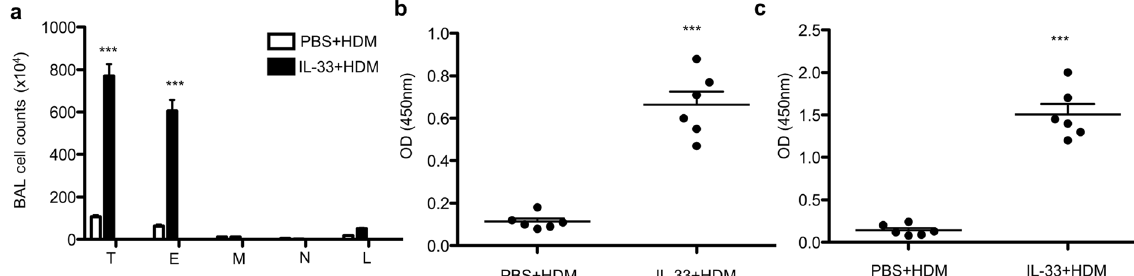
Figure 3. Skin sensitization with HDM + IL-33 induces airway inflammation. ( a ) Cell counts in the BAL fluid. ( b ) HDM-specific IgE in BAL fluid. ( c ) HDM-specific IgE in serum. T, total cells; E, eosinophils; M, macrophages; N, Neutrophils; L, lymphocytes. Data were pooled from two independent experiments (n = 6). Error bars indicate the mean ± SD. *** p ≤ 0.001.